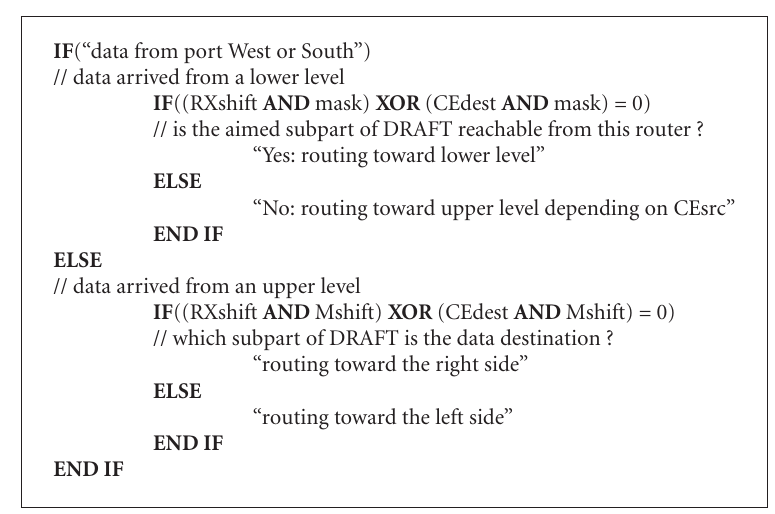
Algorithm 1: Routing algorithm implemented into DRAFT